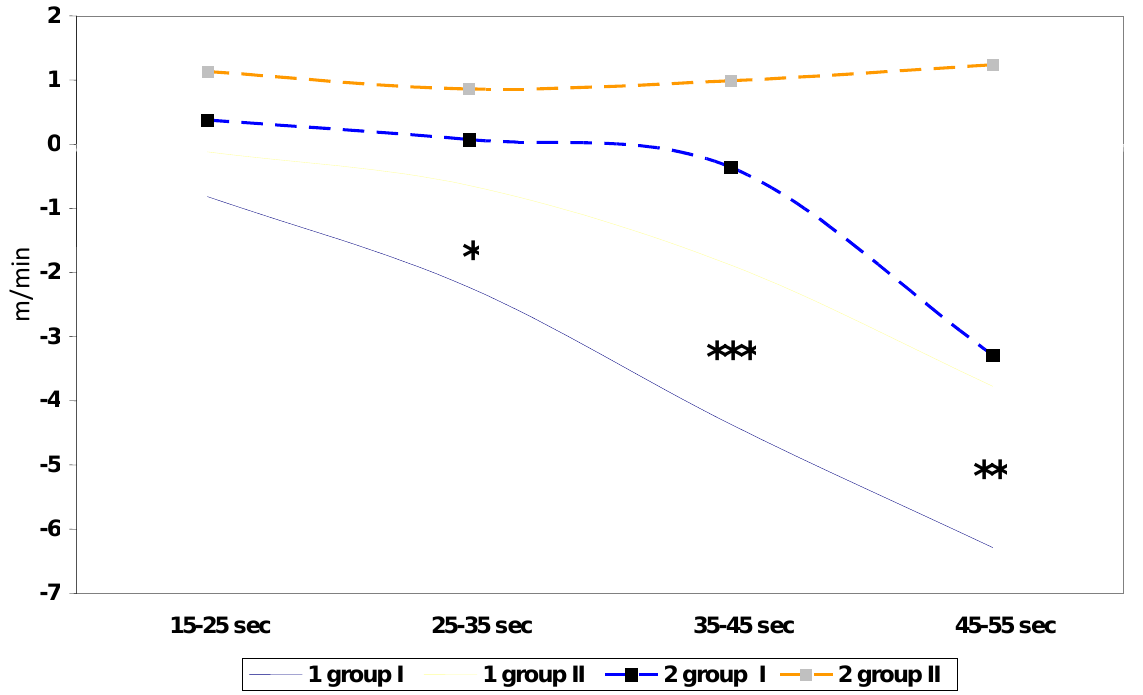
Fig.1 Changes of workability during test in ordinary mode and in feedback mode (persons with different workability’s level). * - р<0.05; ** - р<0.01; *** -